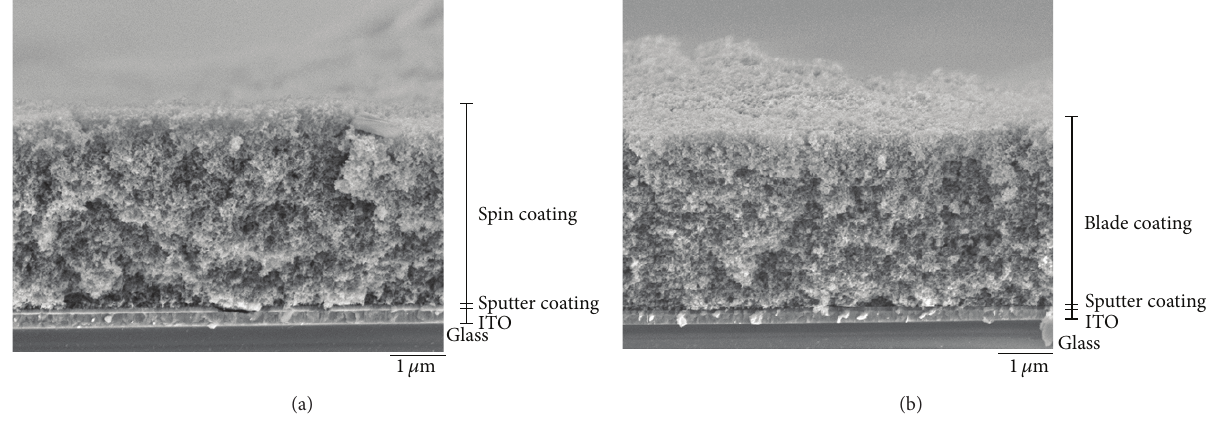
Figure 4: The SEM cross-sectional image of TiO 2 (a) corresponding to Figure 3(b) and (b) corresponding to Figure 3(c). Table 6: The performance of a DSSC prepared using a photoelectrode with and without a TiO electrodes, and using ITO/glass and